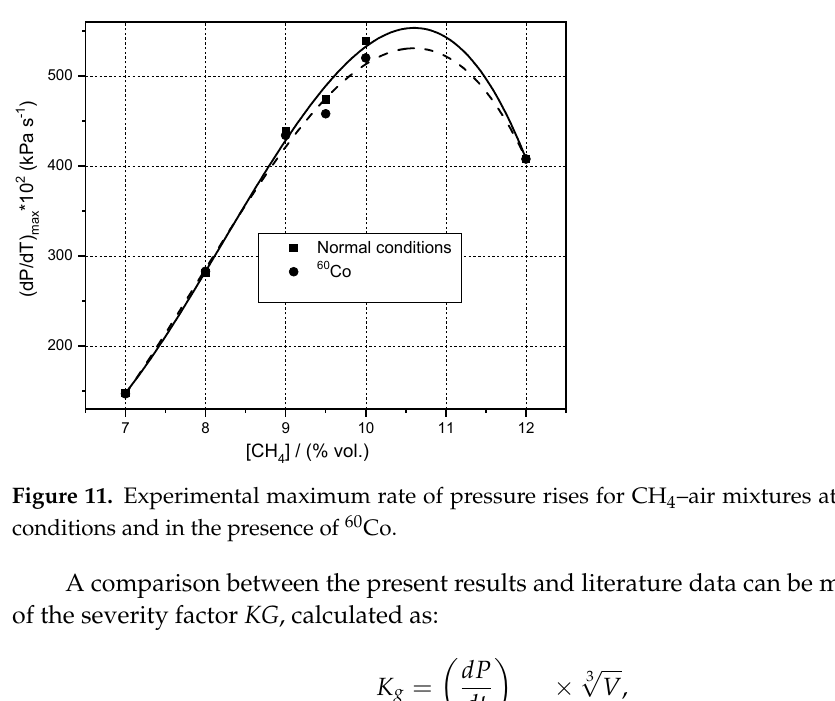
Figure 10. Experimental maximum rate of pressure rises at different initial pressures and compo- sition for CH 4– air mixtures.